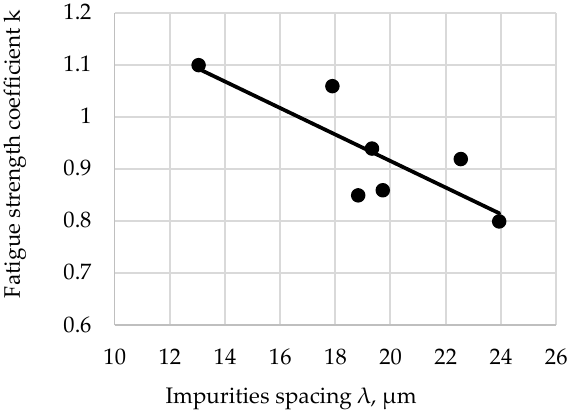
Figure 6. Fatigue strength coefficient, k, of the tested steel after hardening from 880 °C and temper- ing at 400 °C depends on impurities spacing λ.